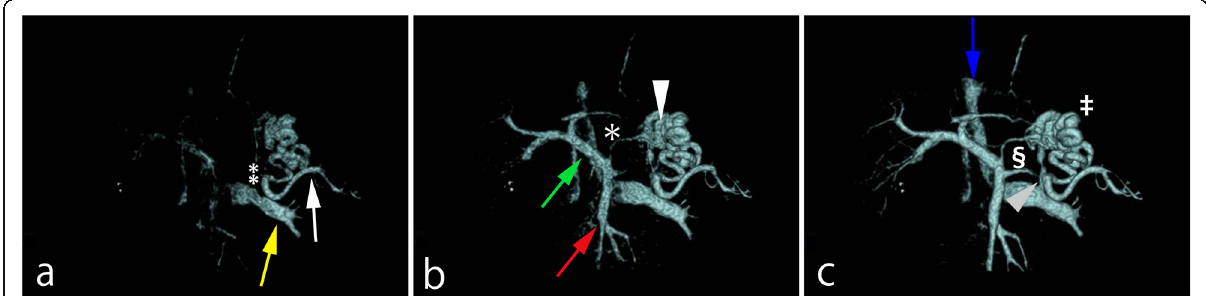
Fig. 2 A 66-year-old male with gastric varices. Volume rendering images, anterior aspect. All of the portal venous system except the central splenic vein shows hepatopetal flow. a Early image depicts a peripheral splenic vein (white arrow), retro gastric vein (double asterisk), and the left renal vein (yellow arrow). b Mid-phase image additionally depicts the superior mesenteric and portal veins (red and green arrows, respectively), the left gastric vein (asterisk), and gastric varices (white arrowhead). c Late image depicts the gastrorenal shunt (gray arrowhead) behind the splenic vein, the inferior vena cava (blue arrow), and central splenic vein (section), which shows hepatofugal flow into the posterior gastric vein. The portosystemic shunt (double dagger) is composed of afferent veins (left gastric and retro gastric veins) and an efferent vein (gastrorenal